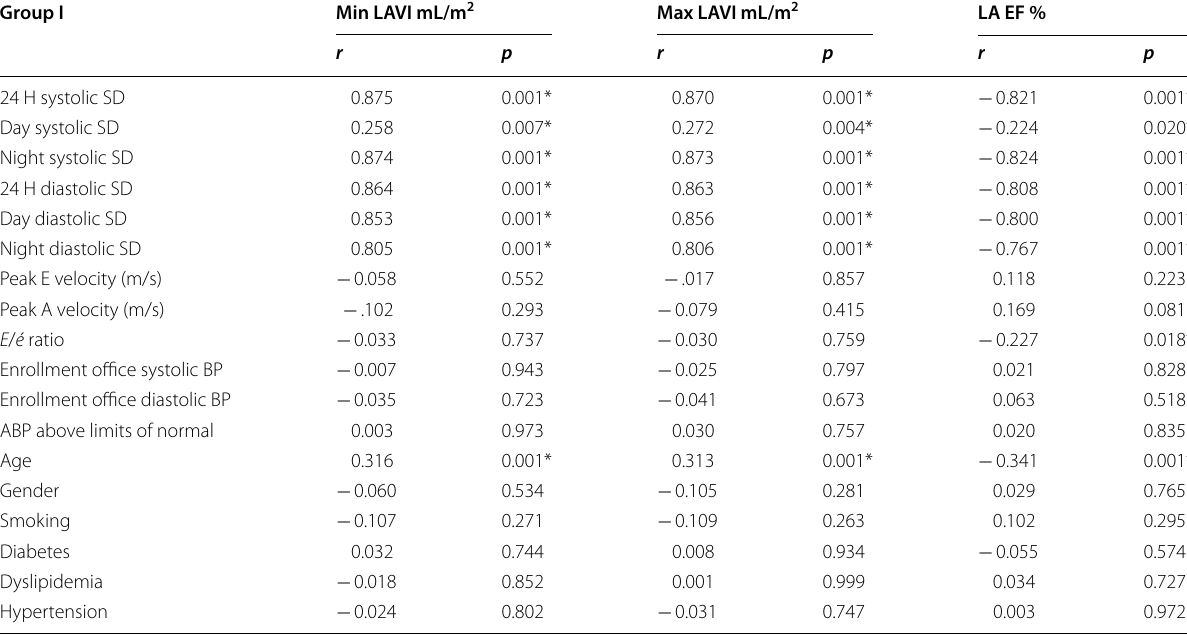
Table 4 Correlation between echocardiographic parameters and the demographic data in Group I